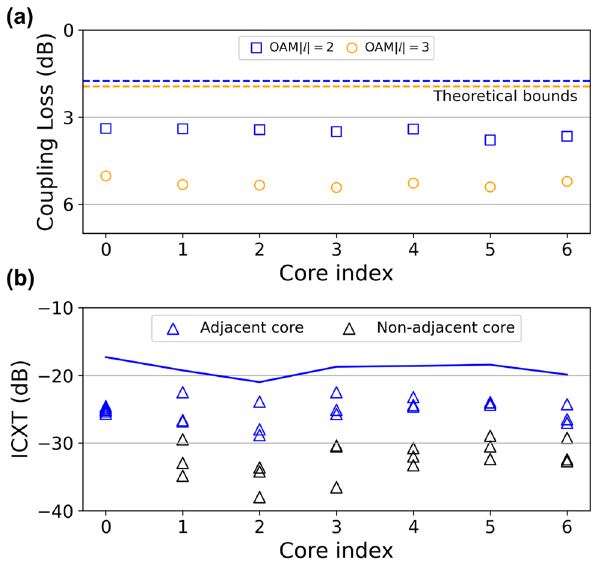
Figure 4: The characterization of the proposed '7-to-7' coupling scheme. (a) Measured insertion loss over seven cores. Dashed lines represent the theoretical lowest coupling loss. (b) Measured inter- core crosstalk. The blue solid line represents the aggregated inter- core